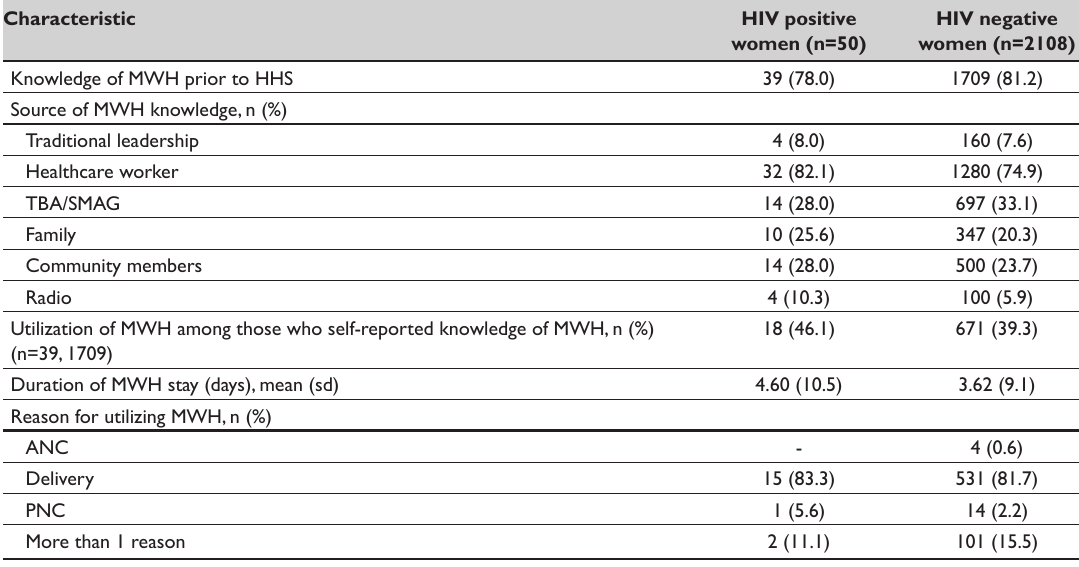
Table II: Maternity waiting home awareness and utilization stratified by self-reported maternal HIV status of women that live >9.5 km away from a health facility Characteristic HIV positive